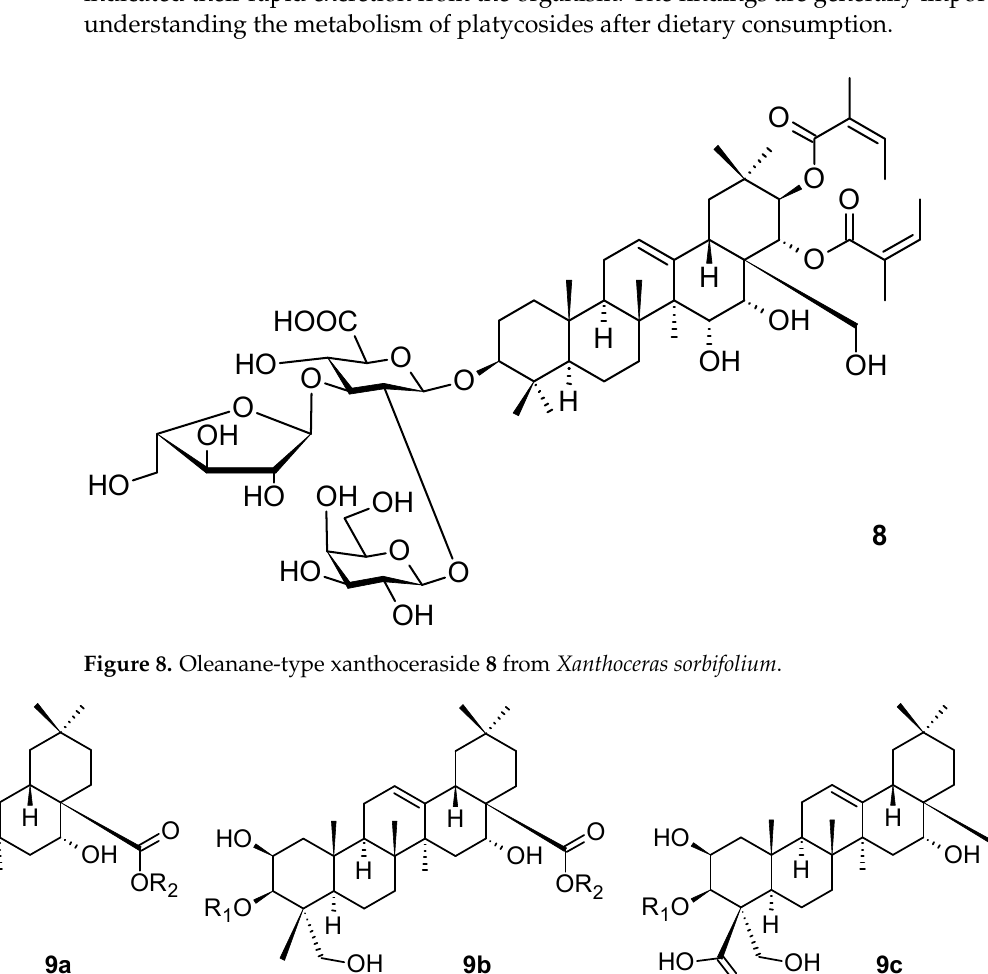
Figure 9. Oleanane-type platycosides from Platycodon grandiflorus. Glycyrrhizic acid ( 1d ; Figure 1) and glycyrrhetinic acid 3 β - D -glucuronide ( 10 ; Figure